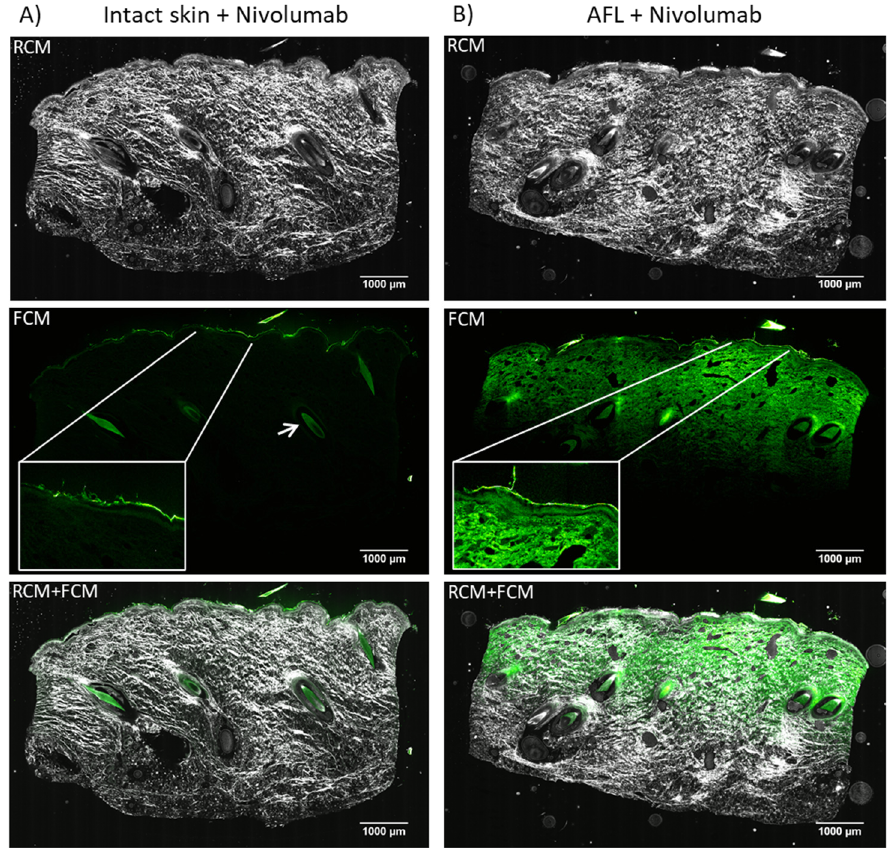
Figure 2. Cutaneous biodistribution of nivolumab (150 kDa). Imaging using ex vivo confocal microscopy of ex vivo porcine skin exposed to 20 h passive diffusion in a Franz cell setup. ( A ) Vertical tissue sections of intact skin exposed to fluorescently (HiLyte Fluor 488 SE) labeled nivolumab ( n = 3). Remnant was observed on the skin surface (box with close-up) as well as autofluorescence throughout dermis and from the hair follicles in particular (arrow). ( B ) Vertical tissue sections exposed to AFL followed by topically applied fluorescently labeled nivolumab ( n = 3). Imaging of nivolumab biodistribution showed a homogenous, horizontal band-like uptake that faded with depth. The uptake reached mid-dermis measured to a median tissue depth of 1967 µm. No accumulation of nivolumab was seen in any specific tissue compartment. LUT in ImageJ: Green Hot. AFL: ablative fractional laser. RCM: Reflectance mode. FCM: Fluorescent mode.